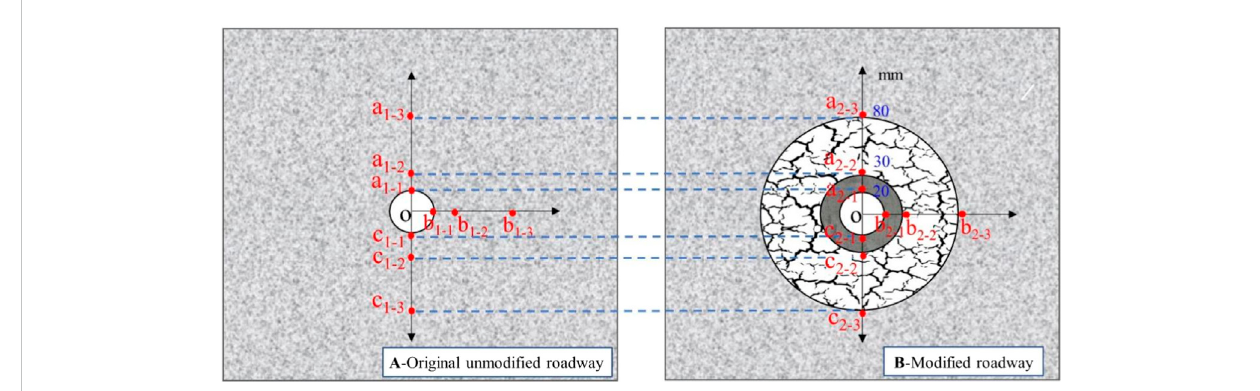
FIGURE 4 Stress monitoring point layout of the physical model with (A) original unmodi fi ed roadway, (B) modi fi ed